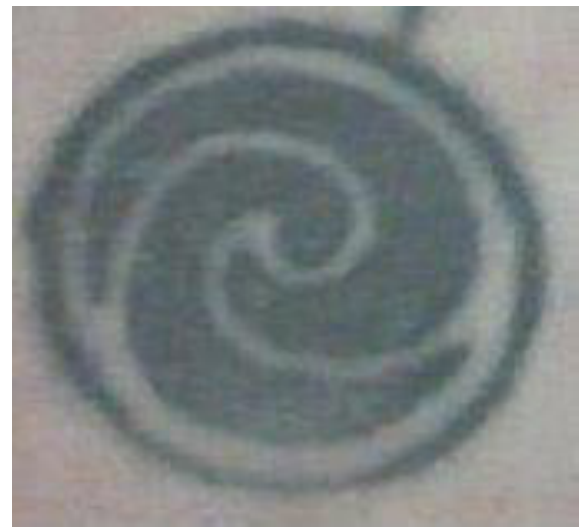
Figure 2. One of Erin‘s two tattoos on the inside of her